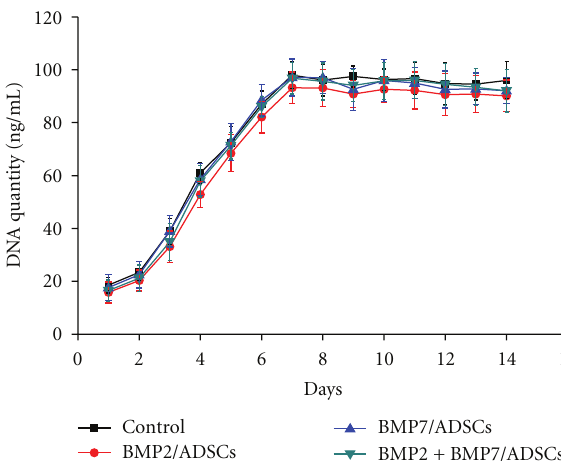
Figure 1: The proliferation curves of control group, BMP2/ADSCs group, BMP7/ADSCs group, and BMP2 + BMP7/ADSCs group on the β -TCP sca ff olds for two weeks after cell seeding. Results are shown as mean ± SD ( n = 3 for each group).